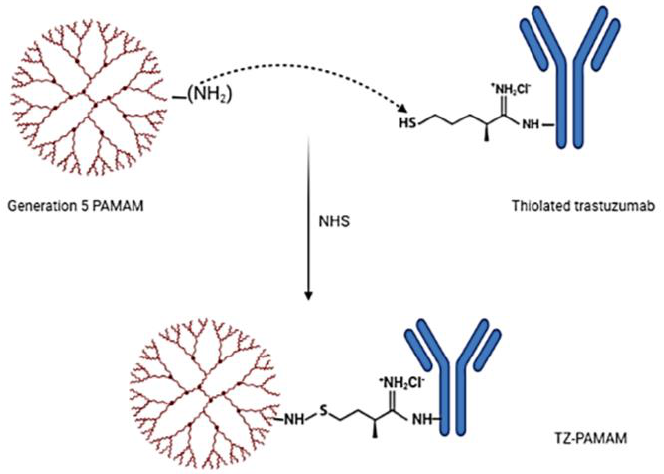
Figure 3. Schematic diagram illustrating the synthesis of trastuzumab (TZ)-grafted G5 poly(amido) amine (PAMAM) dendrimers (created with BioRender.com, accessed 6 December 2022). The anticancer efficacy of DTX-loaded plain dendrimers (Dend-DTX, 241.7 3.8 g/mL) and trastuzumab dendrimers (TZ-Dend-DTX, 159.5 5.4 g/mL) was evaluated in